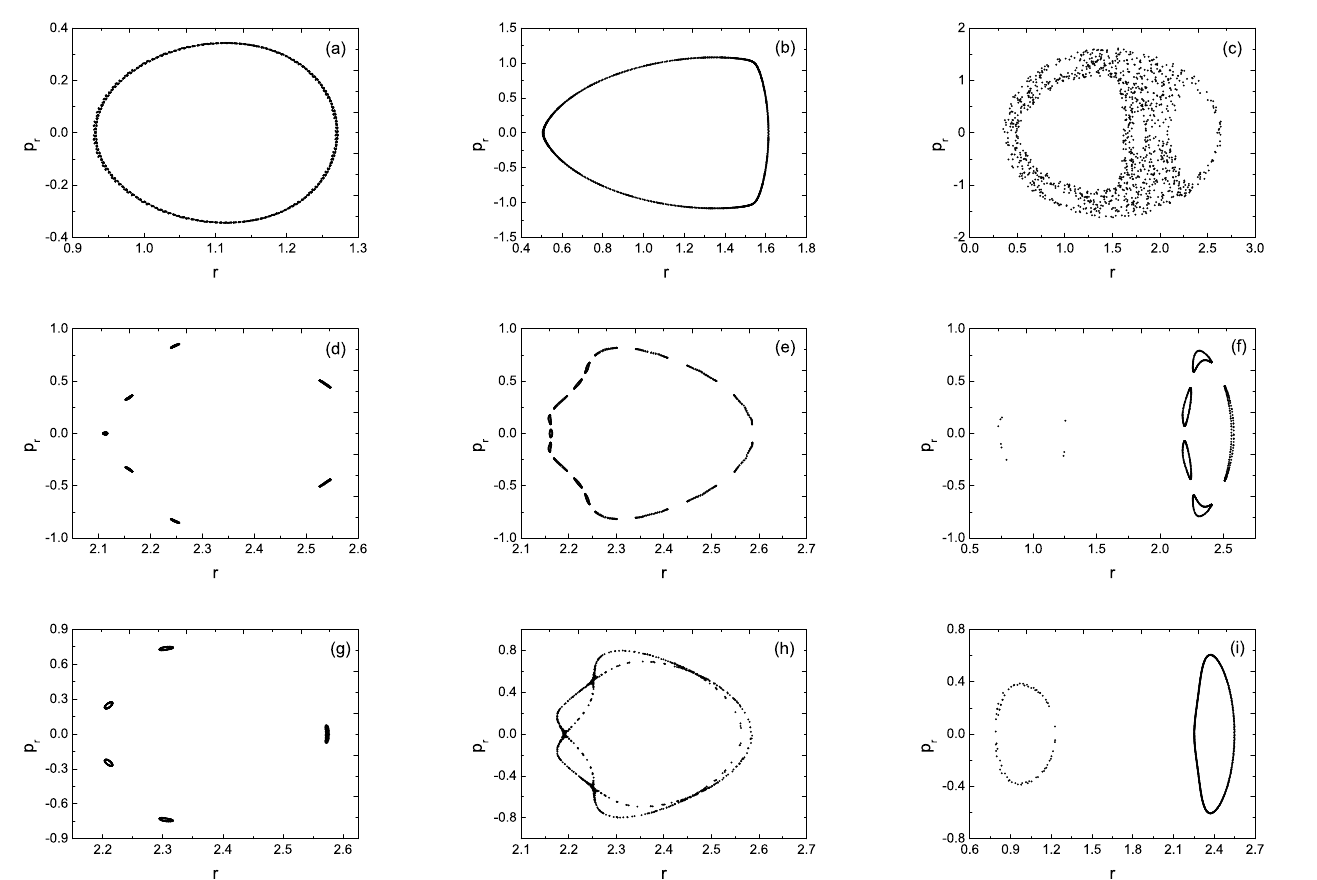
Figure 9. Poincaré sections on the plane ϕ = 0 and p ϕ > 0 for various initial values of ϕ : ( a ) ϕ = 0.05 π , ( b ) ϕ = 0.19 π , ( c ) ϕ = 0.2 π , ( d ) ϕ = 0.35 π , ( e ) ϕ = 0.358 π , ( f ) ϕ = 0.361 π , ( g ) ϕ = 0.366 π , ( h ) ϕ = 0.376 π , and ( i ) ϕ = 0.39 π . The orbit in Figure 7 is a regular single-torus orbit in Figure 8a. Regular single-torus orbits also appear in ( b , e ). The orbits in ( d , f , g , i ) are many-islands tori, but are chaotic in ( c , h ). These results are consistently given by the methods M4, M4P, M4V, N4, N4O, N4P, N4V and